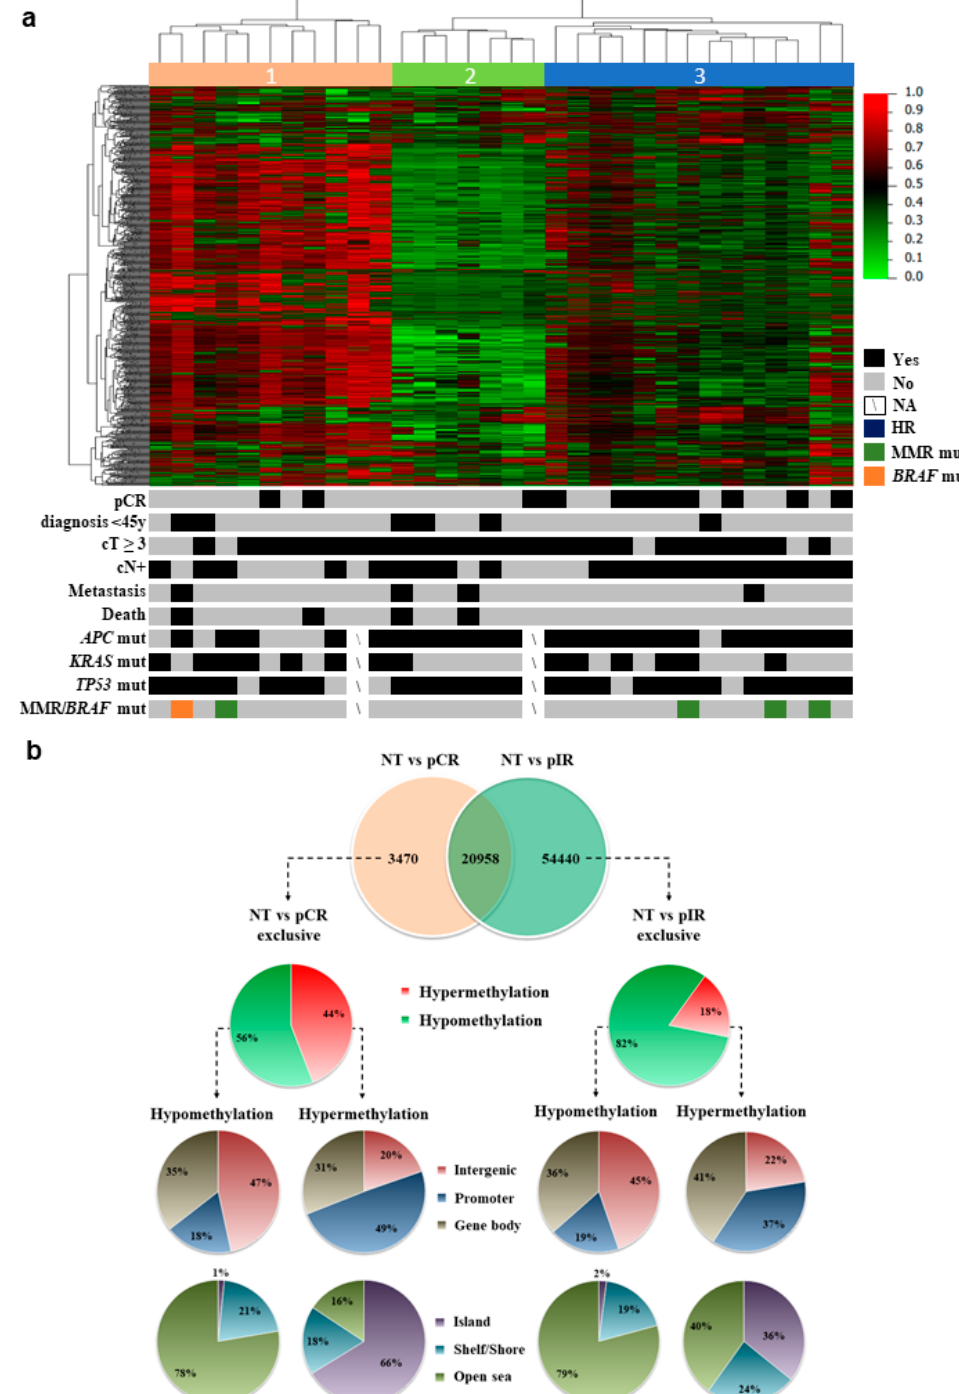
Figure 1. Methylation profile of locally advanced rectal carcinomas (LARC). ( a ) The unsupervised hierarchical clustering analysis of the methylation data using the most variable probes (6284 probes presenting β values with Standard Deviation > 0.2) in the tumor samples revealed three major groups. Rows indicate the CpG sites, while columns represent samples. Clinical features of each case are represented below the heatmap along with targeted next-generation sequencing data for specific genes. Metastases were identified during the follow-up and after the treatment. ( b ) Distribution of the di ff erentially methylated CpG probes in the comparison of pathological complete (pCR) or incomplete (pIR) response and normal tissue (NT) cases. The proportion of CpGs in relation to its location relative to the promoter, gene body, and intergenic regions; and to the CpG islands context was based on the Illumina EPIC